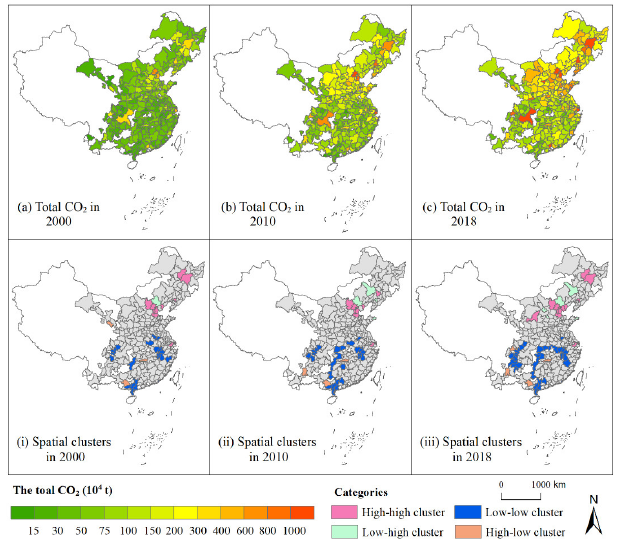
Figure 1. Spatial distribution and clusters of total CO 2 in the years 2001, 2010, and 2018. (( a – c ) represents the spatial distributions of the total CO 2 in 2000, 2010 and 2018, respectively; ( i – iii ) denotes the spatial clusters of the total CO 2 in 2000, 2010 and 2018, respectively).